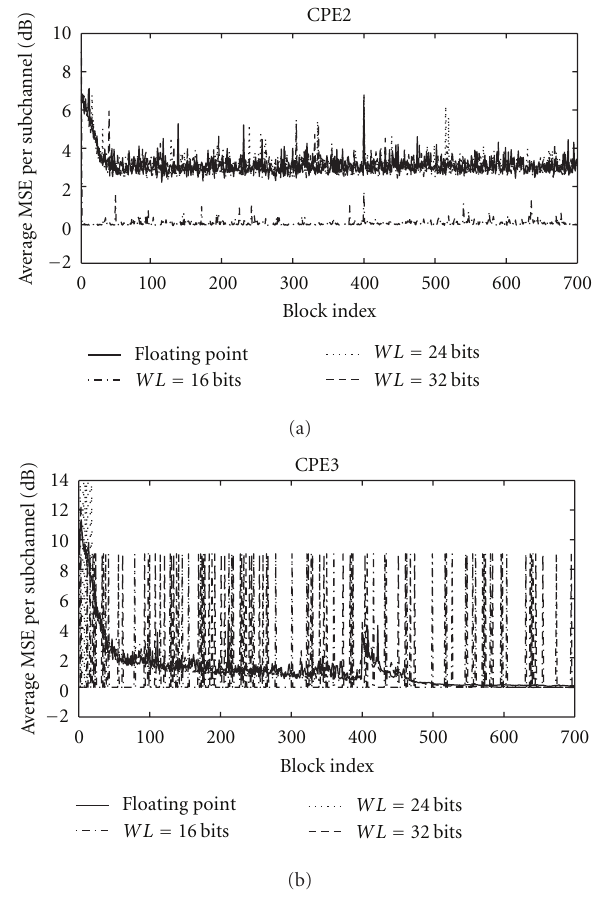
Figure 8: Plots of fixed-point performance of CPE2 (top) and CPE3 (bottom) with three choices of quantization bits ( λ = 0 . 75, 4-